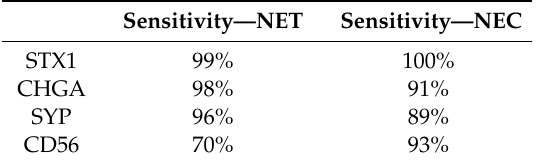
Table 2. Sensitivity of STX1, CHGA1, SYP, and CD56 in NETs and NECs.